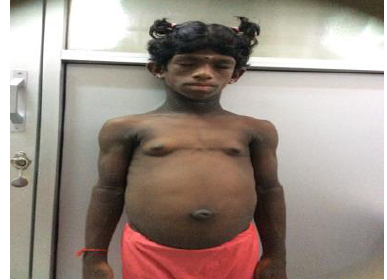
Figure 2: Umbilical Hernia and Right hemi hyperplasia in a child with BWS